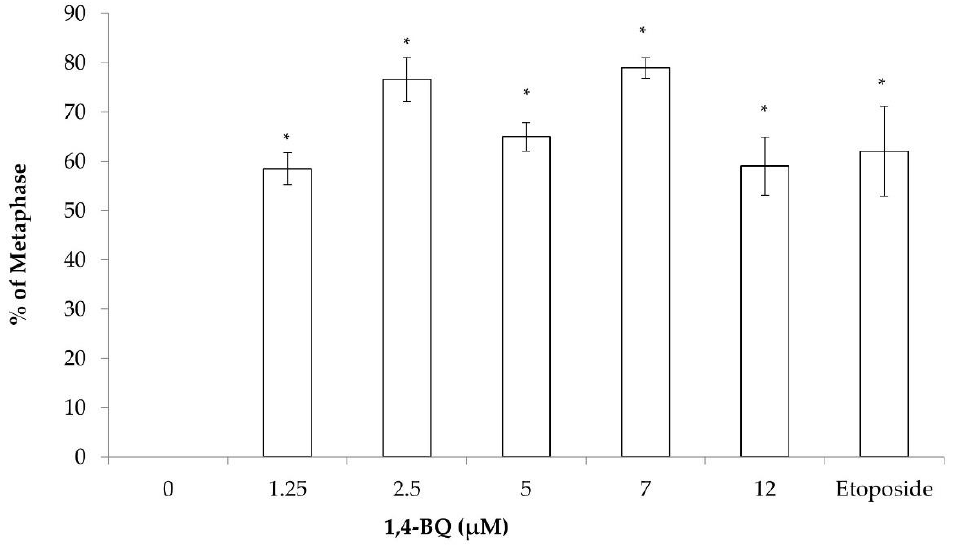
Figure 7. CA of Pre-B lymphoid progenitor cells harvested after 7 days of CFU assay following pre-exposure of MBMCs to 1,4-BQ for 24 h. Twenty metaphases were scored for each experimental group and the percentage of CA is as presented. Data are presented as the mean ± S.E.M. ( n = 3) and analyzed by using one-way ANOVA. * p < 0.05 compared with the negative control group.